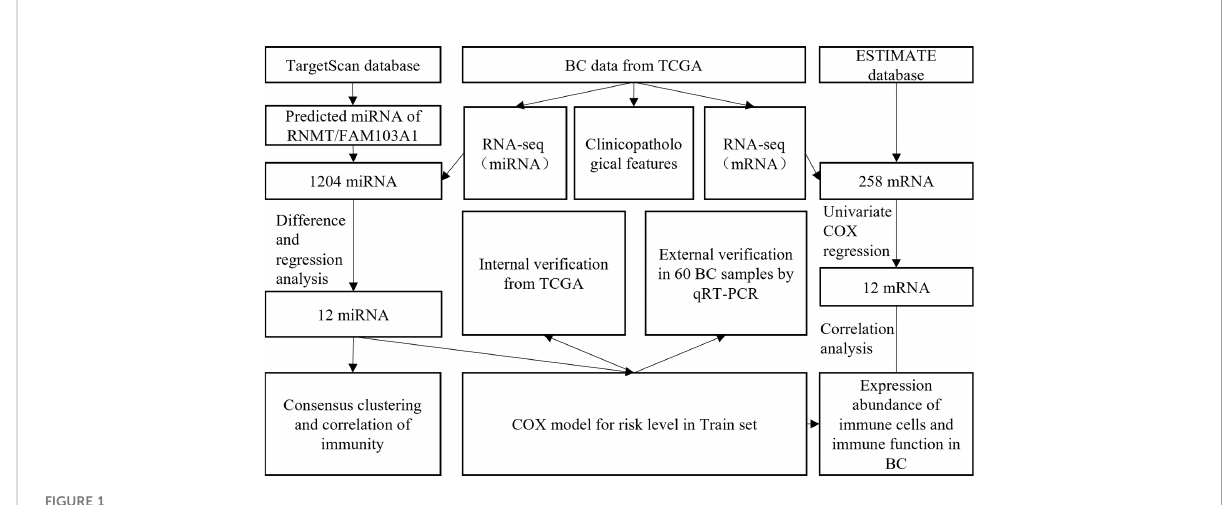
FIGURE 1 Flow chart of the present